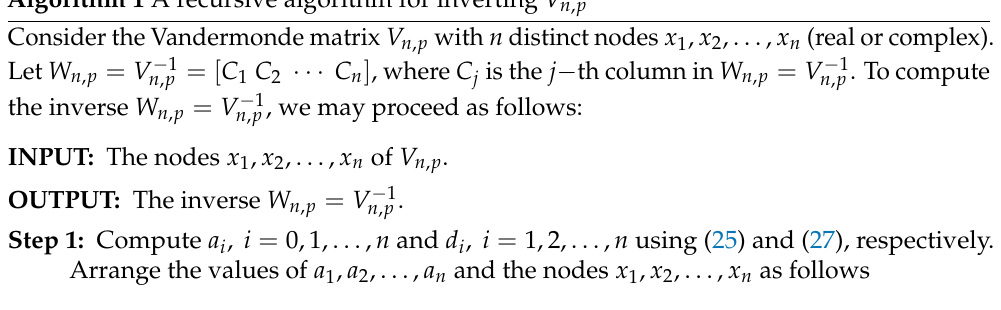
Algorithm 1 A recursive algorithm for inverting V n ,